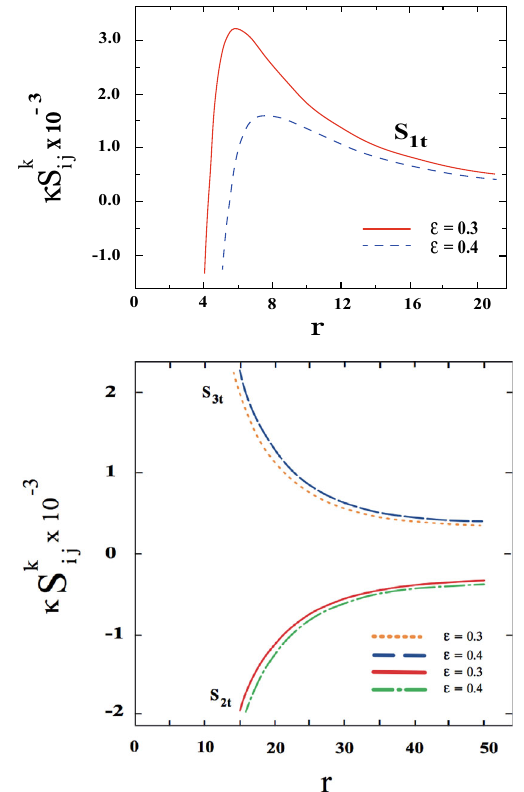
Fig. 8 These Graphs show the contribution of the torsion to the com- ponents of the spin current density on the upper panel, s 1 t is shown. The lower panel, shows s 2 t and s 3 t , with κη 2 = 0 . 3 e 0 . 4 and L = 10 3